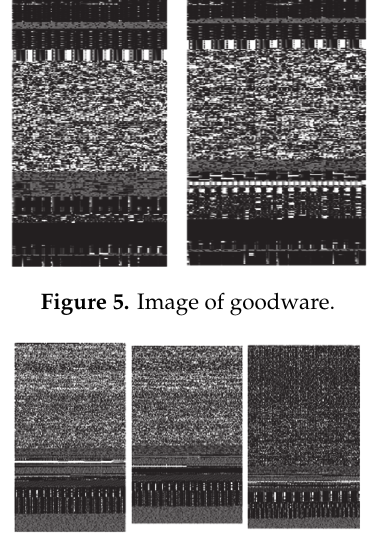
Figure 6. Linux malware image examples.